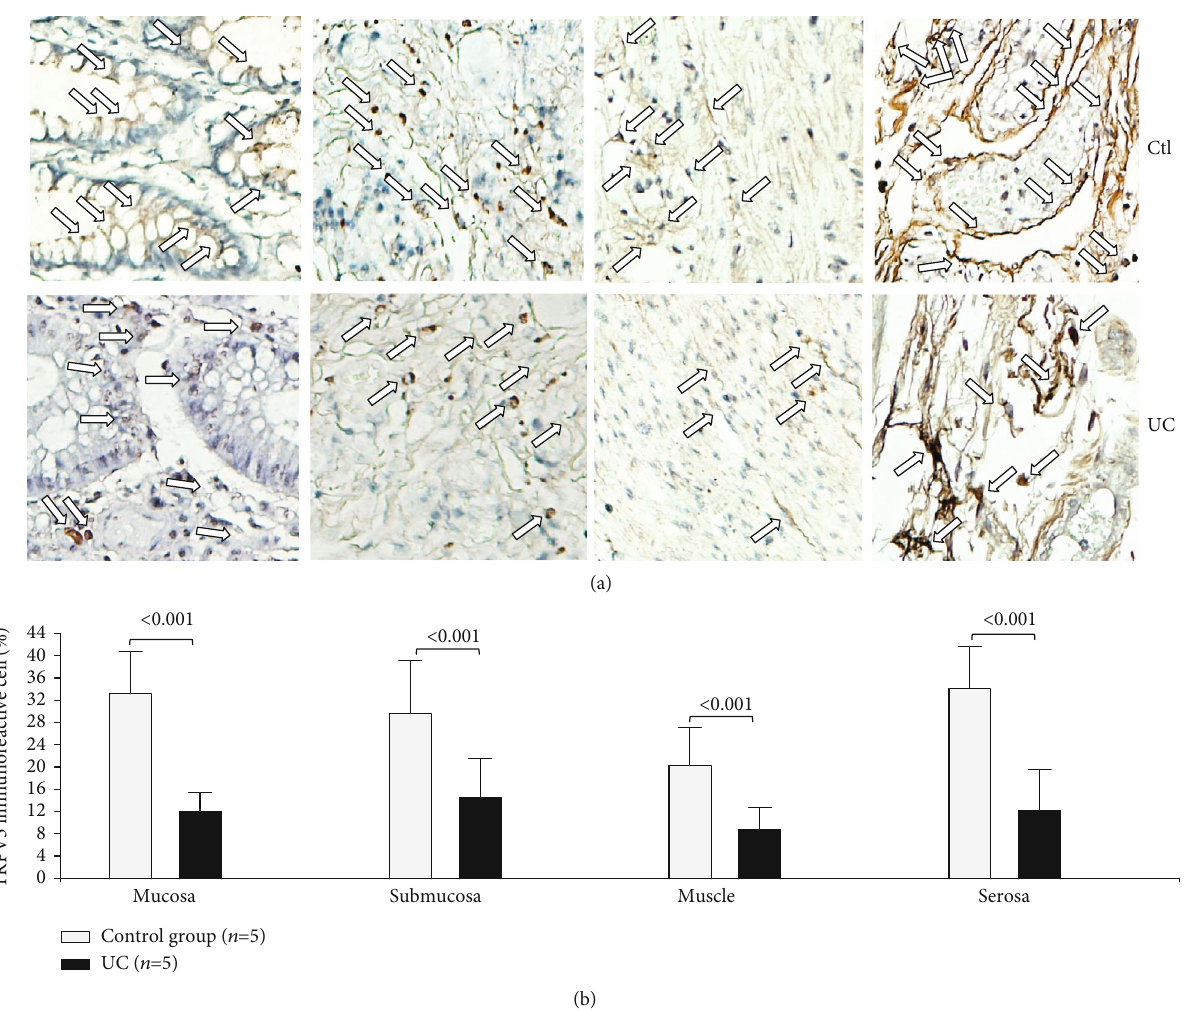
Figure 3: Protein expression of TRPV3 in intestinal tissue from patients with UC and controls. TRPV3 protein expression in slides with colonic tissue obtained from patients with severe ulcerative colitis and nonin fl amed colonic tissue. (a) Immunoperoxidase photomicrographs of ulcerative colitis (lower panel, n = 5 ) and non-IBD colonic tissue (control; upper panel, n = 5 ). Arrows indicate TRPV3 immunoreactive cells in the mucosa, submucosa muscular, and serosa layers. Original magni fi cation was × 320. (b) TRPV3-producing cell percentage in nonin fl amed colonic tissues (control, n = 5 ) and active UC patients ( n = 5 ) is shown in